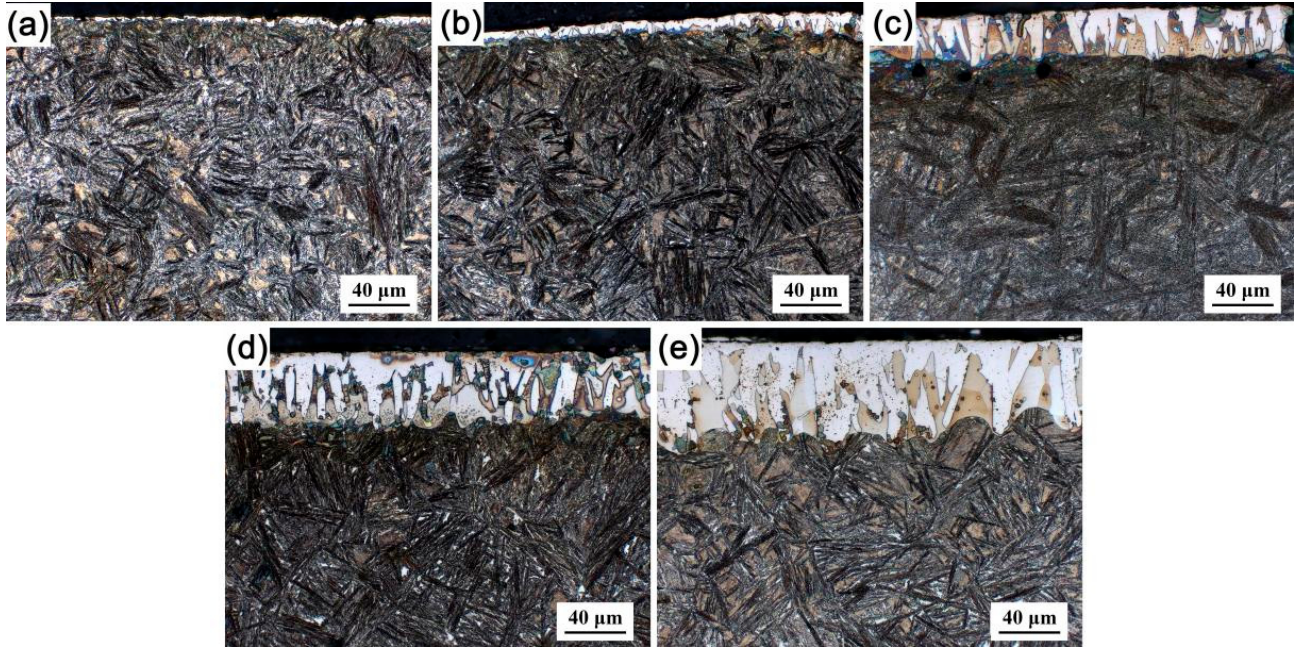
Figure 4. Cross-sectional OM morphologies of boro-austempered samples with different boriding times: ( a ) 0.5 h; ( b ) 1 h; ( c ) 2 h; ( d ) 6 h; ( e ) 8 h.